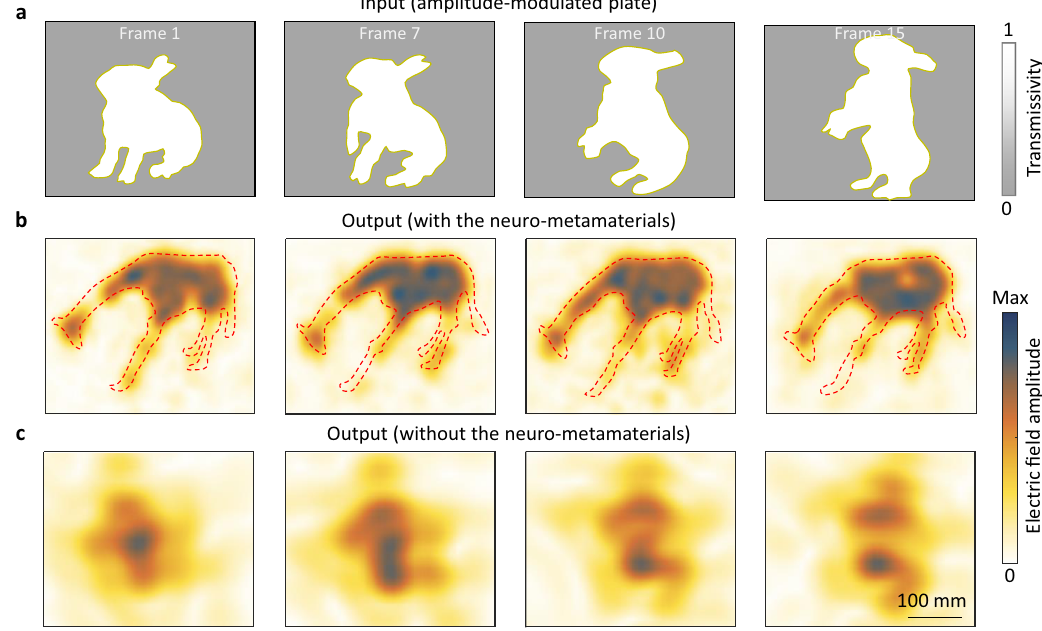
Fig. 5 Experimental demonstration of dynamic optical mirage. a Input rabbit ’ s plates of frames 1, 7, 10, and 15. Input plates encode the amplitude of the input fi eld. b Measured electric fi eld amplitude with the neuro-metamaterials at the output plane. The results clearly show a mirage of giraffe, and the giraffe ’ s head goes down gradually. c Measured electric fi eld amplitude without the